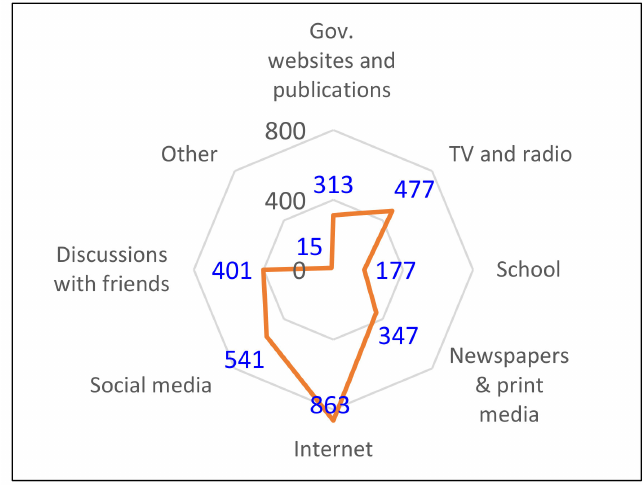
Figure 3. Public information sources on water and wastewater.